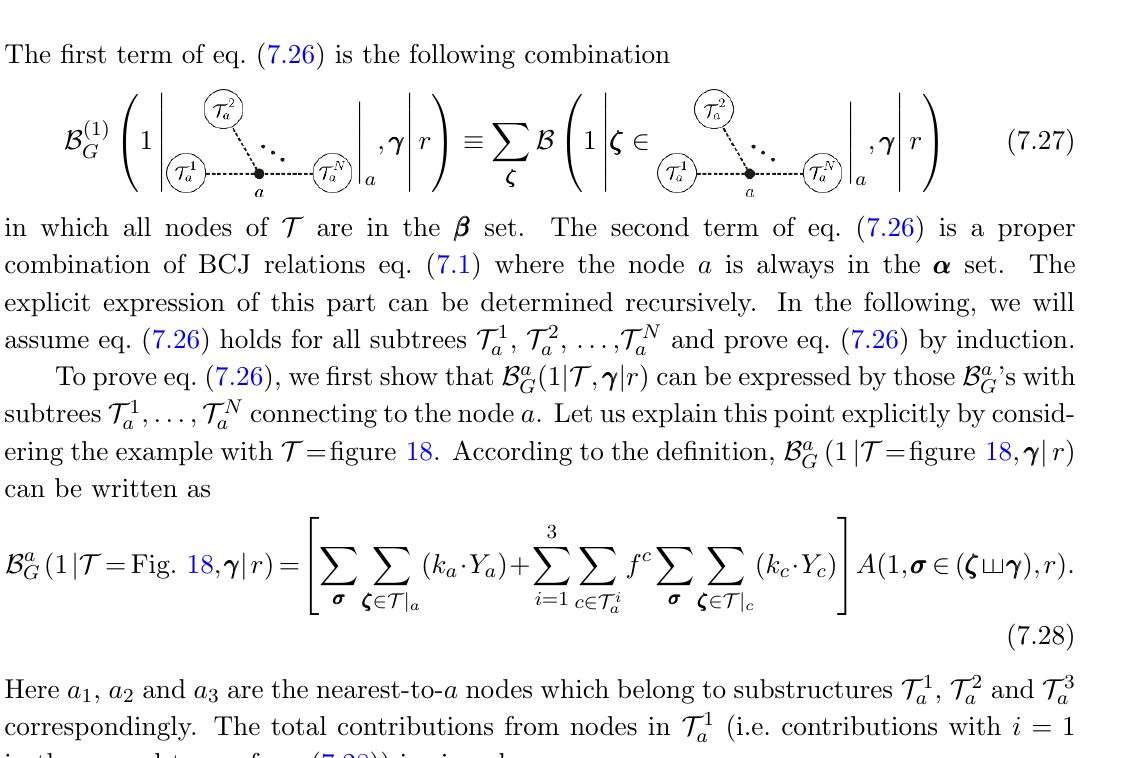
, T 2 and T 3 a a a